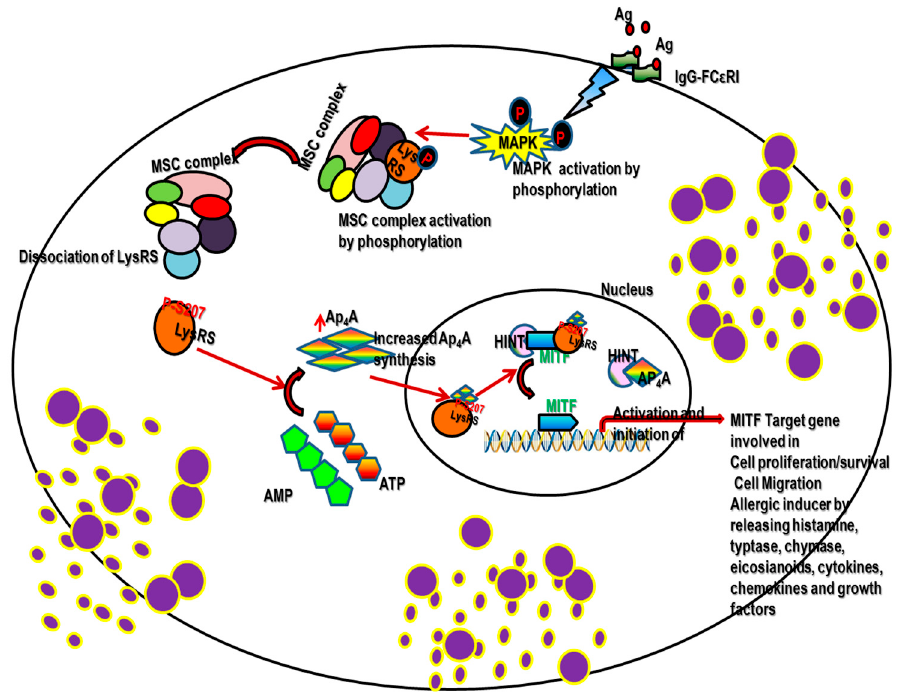
Figure 1. Demonstrates the schematic diagram of pLysRS-Ap 4 A signaling in mast cell